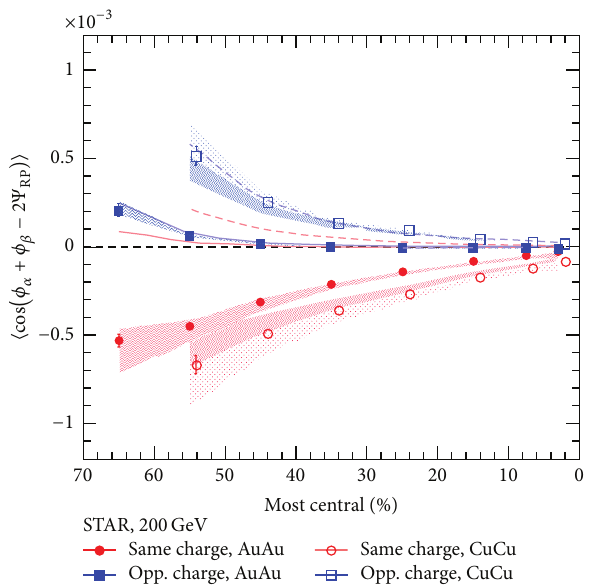
Figure 2: Angular correlations as measured by STAR for Au+Au and Cu+Cu collisions. The shaded areas stand for systematic uncertainties in the analysis relative to the elliptic flow. The figure is taken from